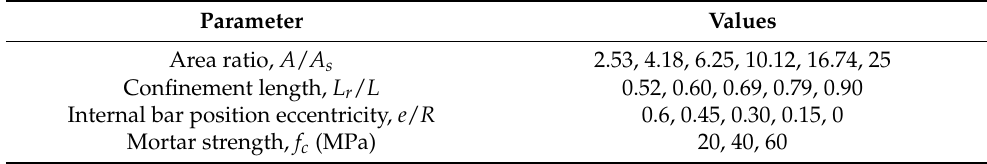
Table 7. Values of the parameters considered in the parametric study.